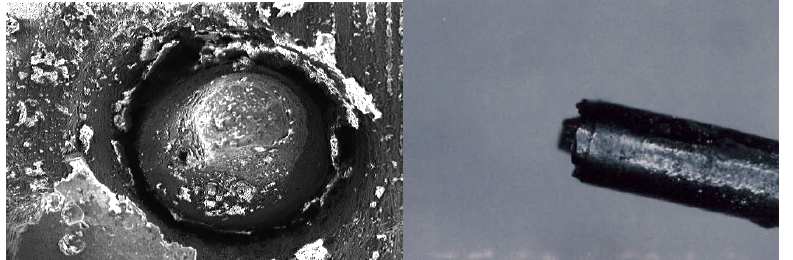
Figure 26. Fracture of the laser welded pin after 154 cycles. Optical examination, magnification 10×, Sample #6.